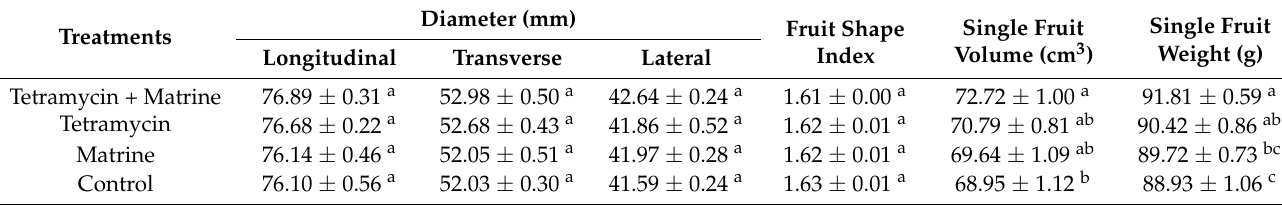
Note: Values indicate the mean ± SD ( n = 3). Different small letters in the same column show significant differences at 5% level ( p <